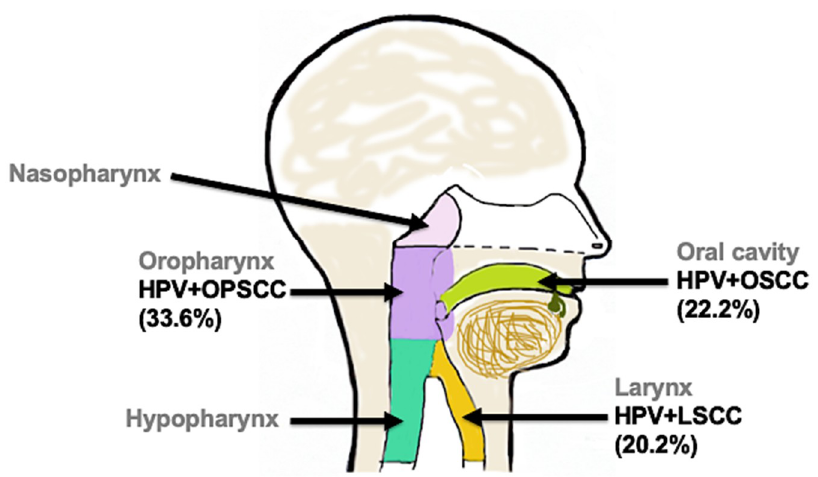
Figure 3. Distribution of human papillomavirus-associated head and neck cancers (HPV + HNC) between anatomical sites. HPV is associated with 33.6% of OPSCC (lavender), 22.2% of OSCC (bright green), and 20.2% of LSCC (gold)